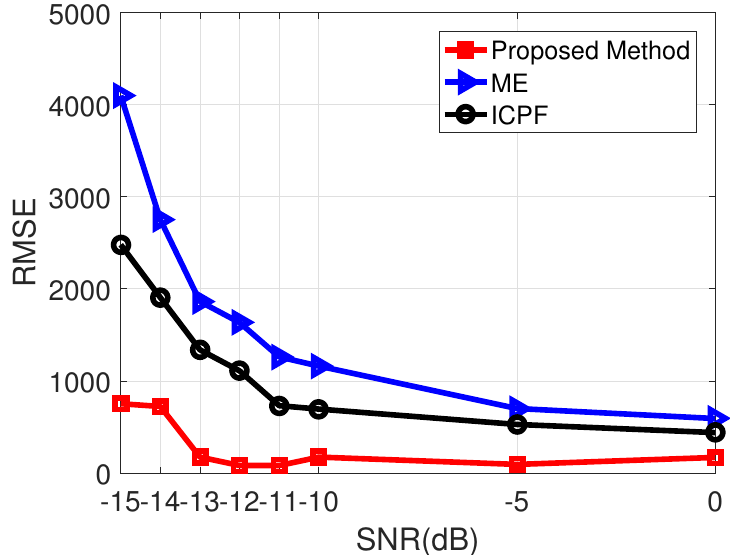
Figure 12. RMSE under different SNRs based on EM simulation